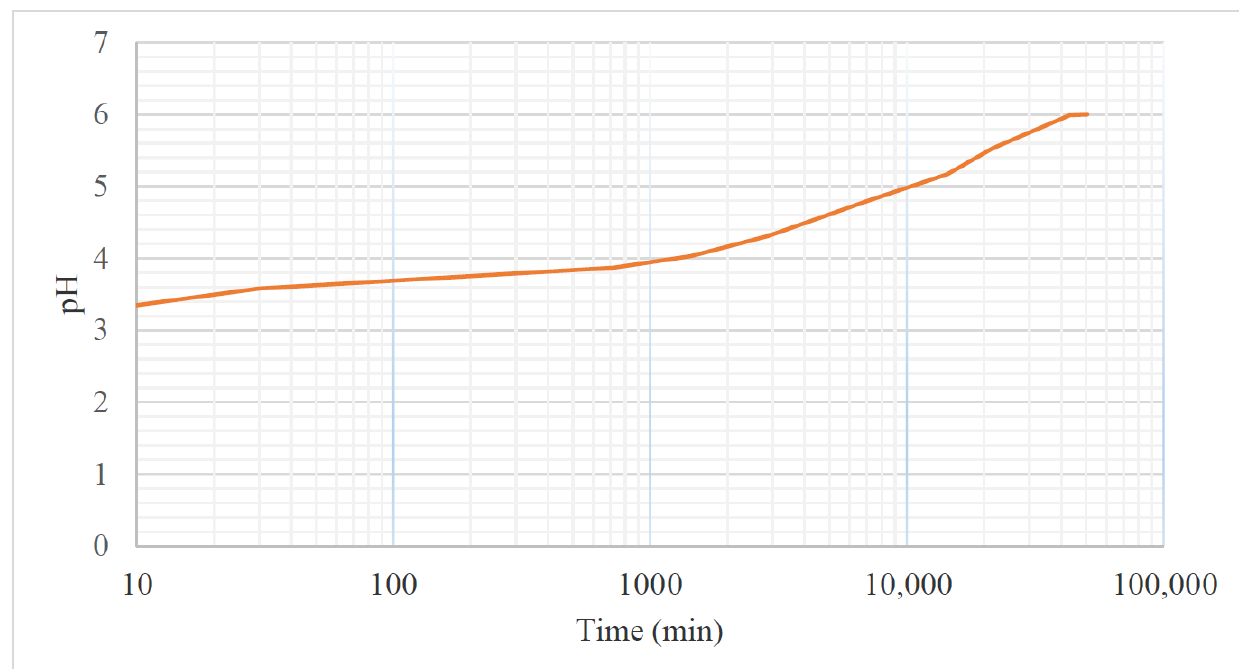
Figure 5. Variation of pH in relation to duration treatment of the AMD with fly ash.